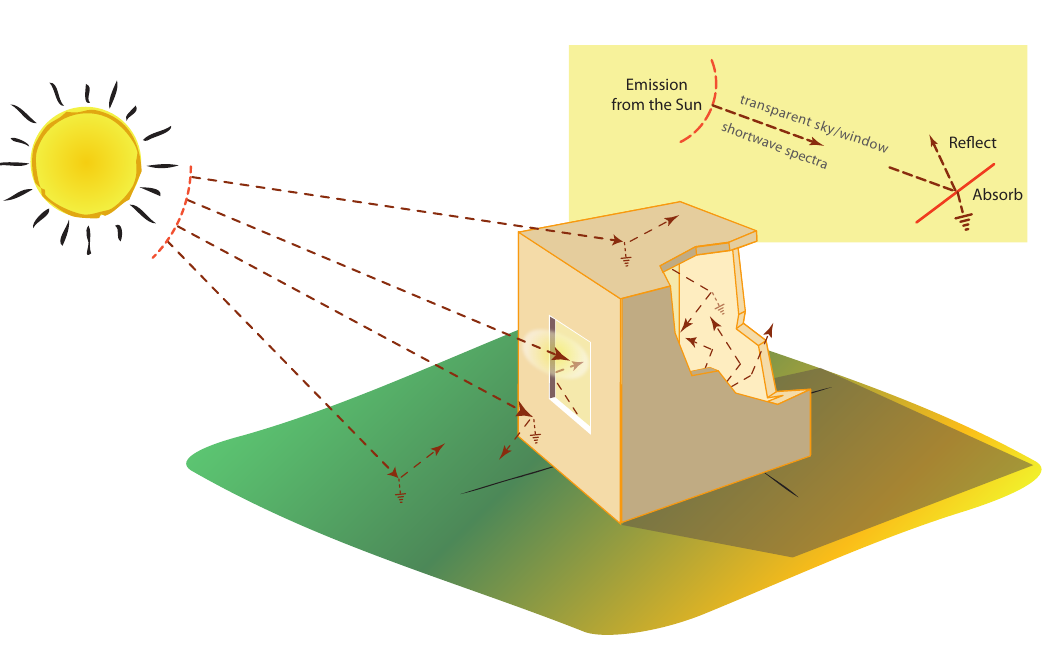
Figure 2. Schematic diagramming shortwave sunlight interacting with the Building and surroundings as a Solar Energy Conversion System.